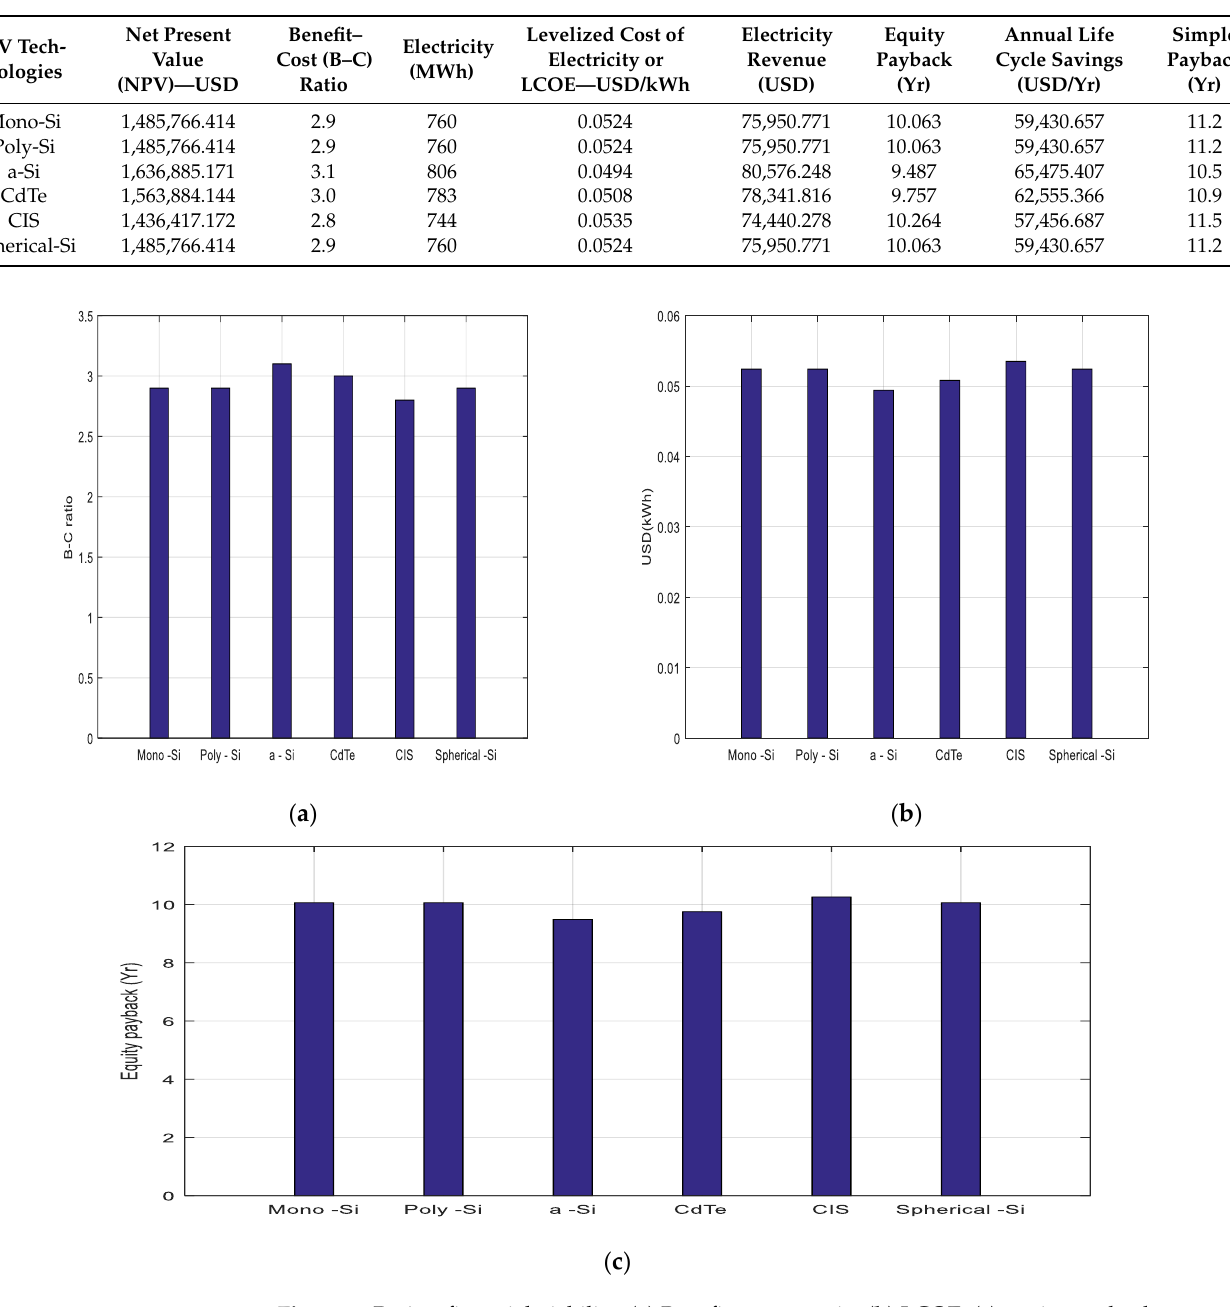
Figure 9. Project financial viability. ( a ) Benefit-to-cost ratio; ( b ) LCOE; ( c ) equity payback.